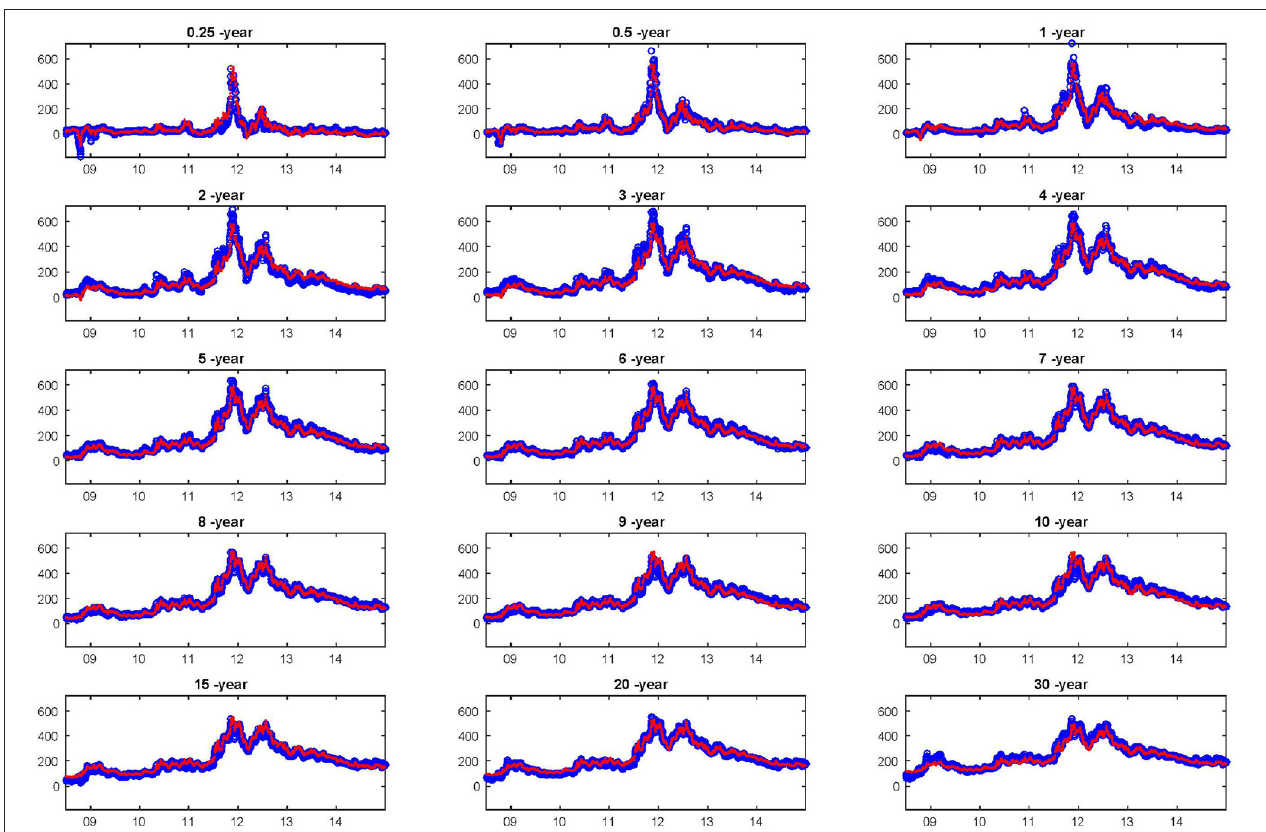
FIGURE 3 | Calibration of the 2-factor default intensity process δ t on the Italy bond yields from January 02, 2008 to December 31, 2014. We report the observed spreads between bond and risk-free rates and the estimated ones for all maturities investigated. The Kalman filter is considered to extract the unobservable default intensity